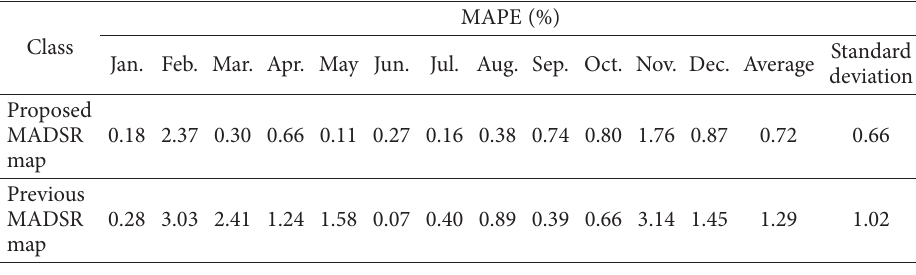
Table 3. Comparison of the estimation accuracy between the proposed and previous MADSR maps (24 measured MADSR data from weather